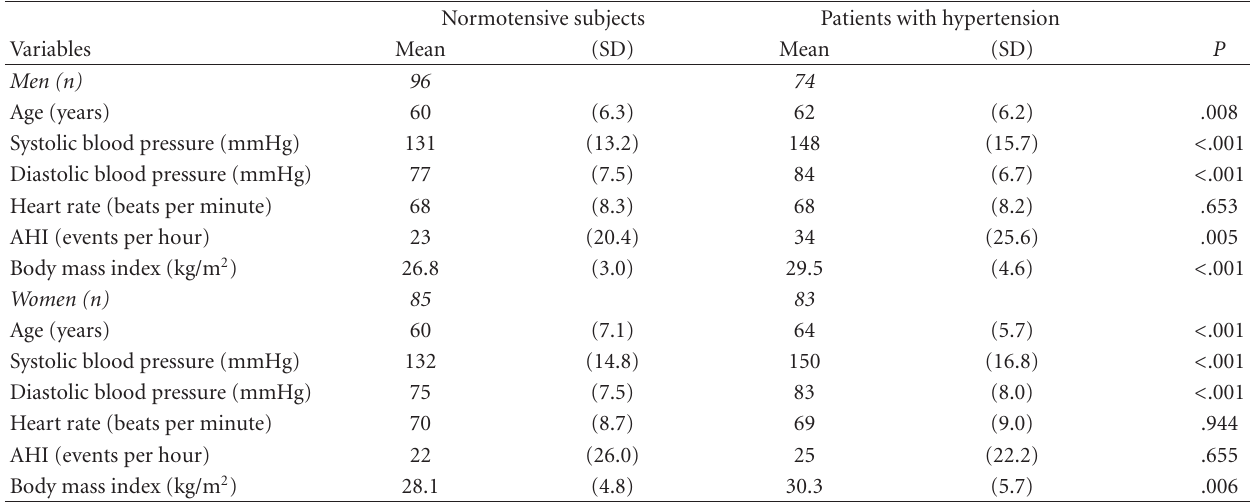
Table 2: Clinical characteristics in normotensive and hypertensive men and women. Normotensive subjects Patients with